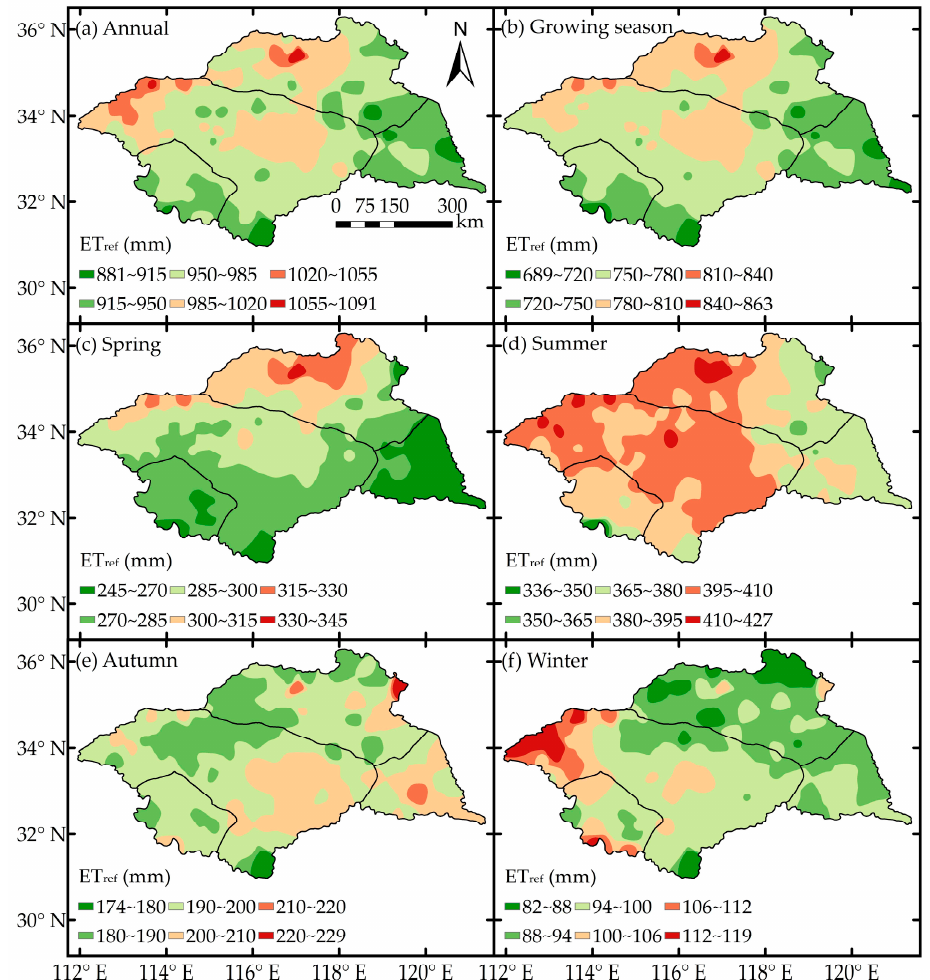
Figure 4. Spatial distribution maps of ( a ) annual; ( b ) growing season; ( c ) spring; ( d ) summer; ( e ) autumn; and ( f ) winter ET ref during 1961–2014 in the HRB.